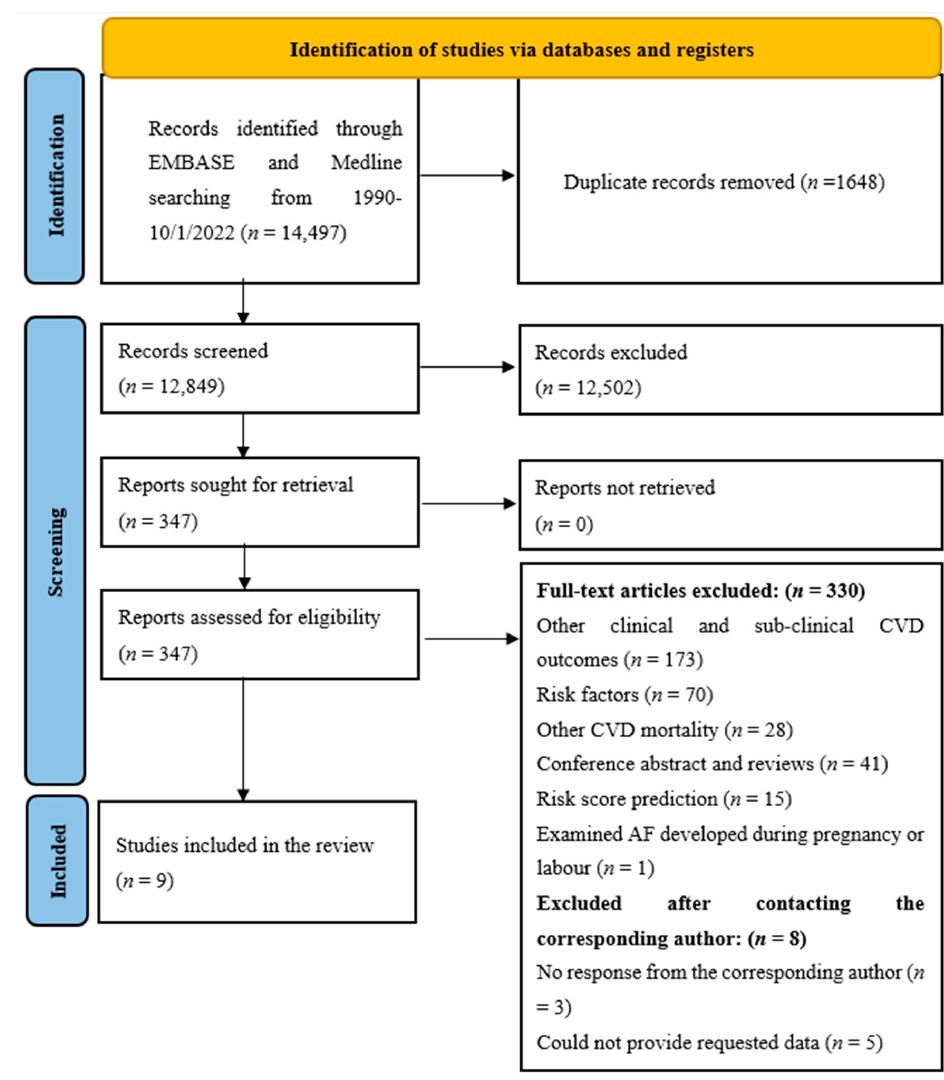
Figure 1. PRISMA flow diagram of study inclusion.